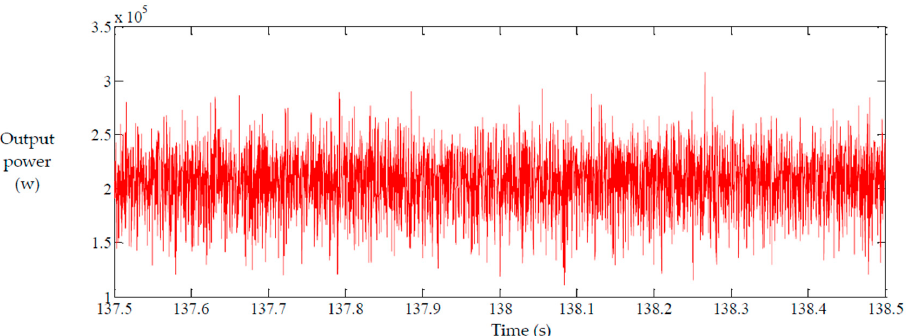
Figure 3. Operation data of the DFIG.